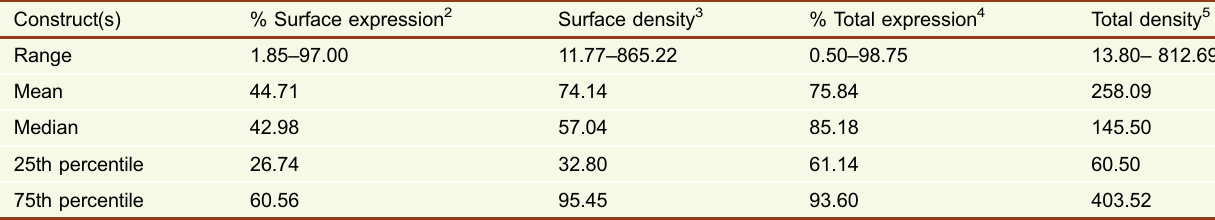
Table 2. Statistics of expression levels among the 1,652 GPCR constructs 1